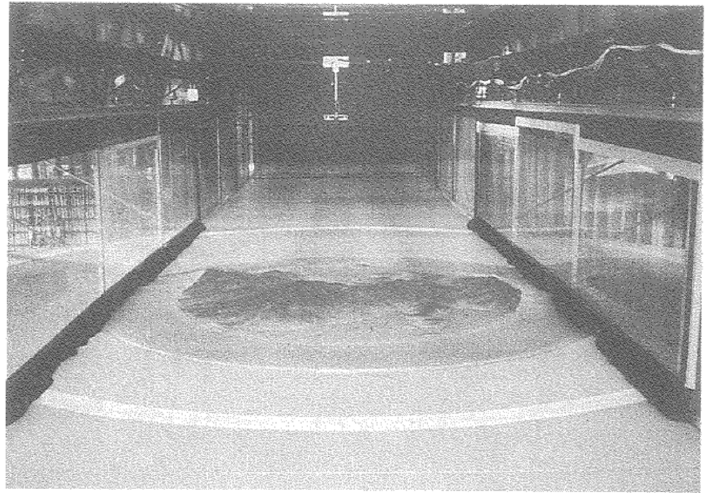
Figure 5. 1:5000 scale model of Mt. Tsukuba installed in the wind tunnel [4].